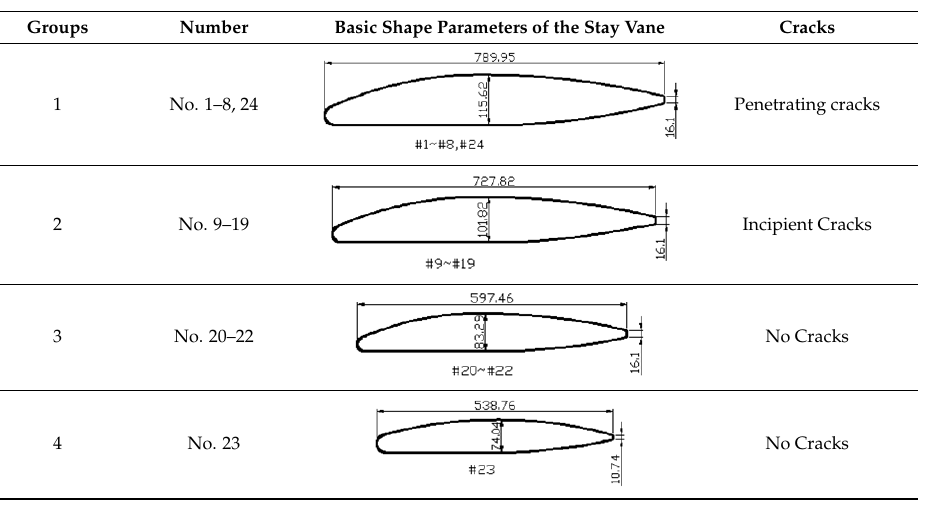
Table 1. Crack detection results of stay vanes.